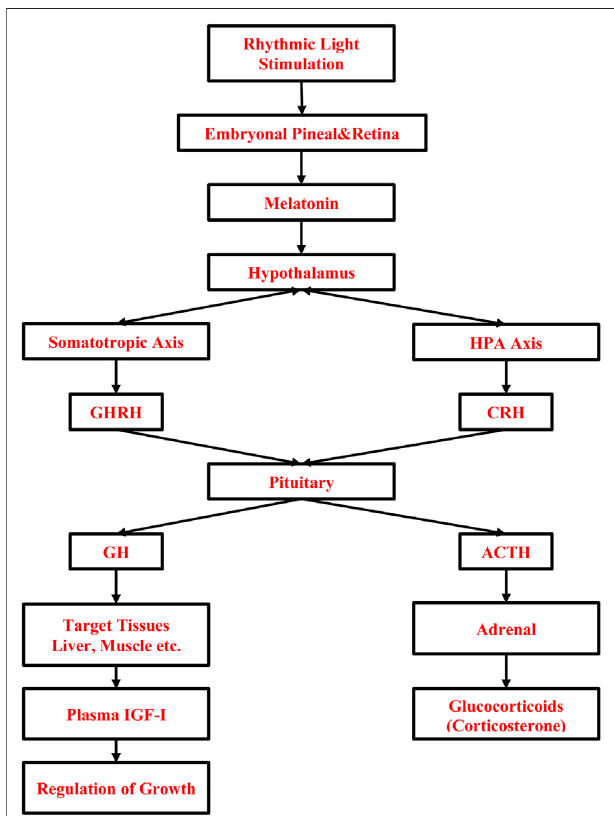
FIGURE 1 | Role of light stimulation during incubation on embryonic muscle growth and stress. HPA, Hypothalamus-Pituitary-Adrenal; GHRH, Growth Hormone-Releasing Hormone; CRH, Corticotrophin Releasing- Hormone; ACTH, Adrenocorticotropic Hormone; TRH, Thyrotropin- Releasing Hormone; GH, Growth Hormone; IGF-1, Insulin-like Growth